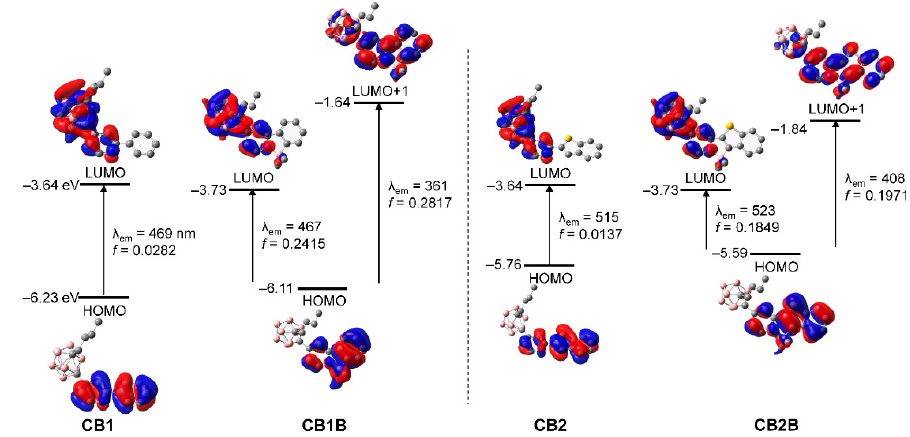
Figure 4. Relative energies of frontier molecular orbitals of o -carboranyl compounds at the first excited singlet state ( S 1 ) calculated by density functional theory (DFT) (isovalue = 0.04). The transition energy (in nm) was calculated at the TD-B3LYP/6-31G(d) level. Table 3. Major low-energy electronic transitions in o -carborane compounds at the first excited singlet state ( S 1 ) calculated at the TD-B3LYP/6-31G(d) level 1 . λ calc /nm f calc Assignment